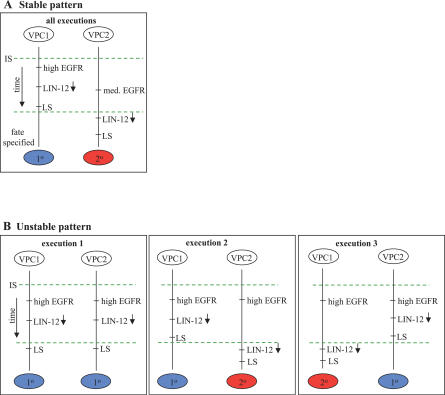
Order of Events in Stable and Unstable Fate PatternsTime flows from top to bottom. Two events that appear on the same vertical line are ordered according to the time flow. The dashed lines synchronize the different vertical lines. All events that appear above a synchronization line occur before all events that appear below the synchronization line. The time-order between two events that appear on parallel vertical lines without a synchronization line is unknown.(A) Proposed sequence of events leading to a stable pattern. The left time line starts with a high inductive signal (IS) and the right time line with a medium IS.(B) Three diagrams that represent possible sequences of events leading to different fate patterns in the absence of IS (the AC is absent). Execution 1 represents the case where two cells are strongly coupled and they both reduce their lin-12 level simultaneously, send LS, which is ignored, and assume primary fates. Execution 2 represents the case where the left cell sends the lateral signal slightly before its neighbor reduces the level of lin-12, thus resulting in a 1°-2° pattern. Execution 3 is the dual of execution 2 where the cell on the right inhibits the cell on the left.